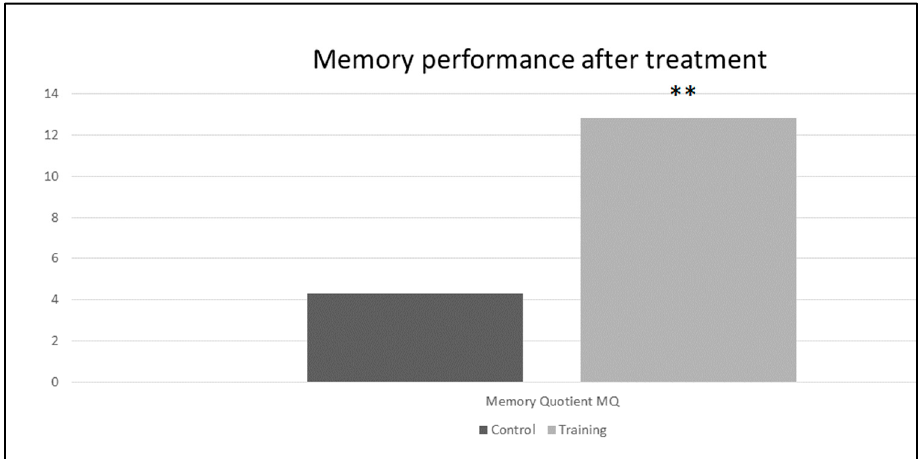
Figure 1. The difference scores at the attention performance. Note: * indicates the statistical significance between within groups comparison for p < 0.05.